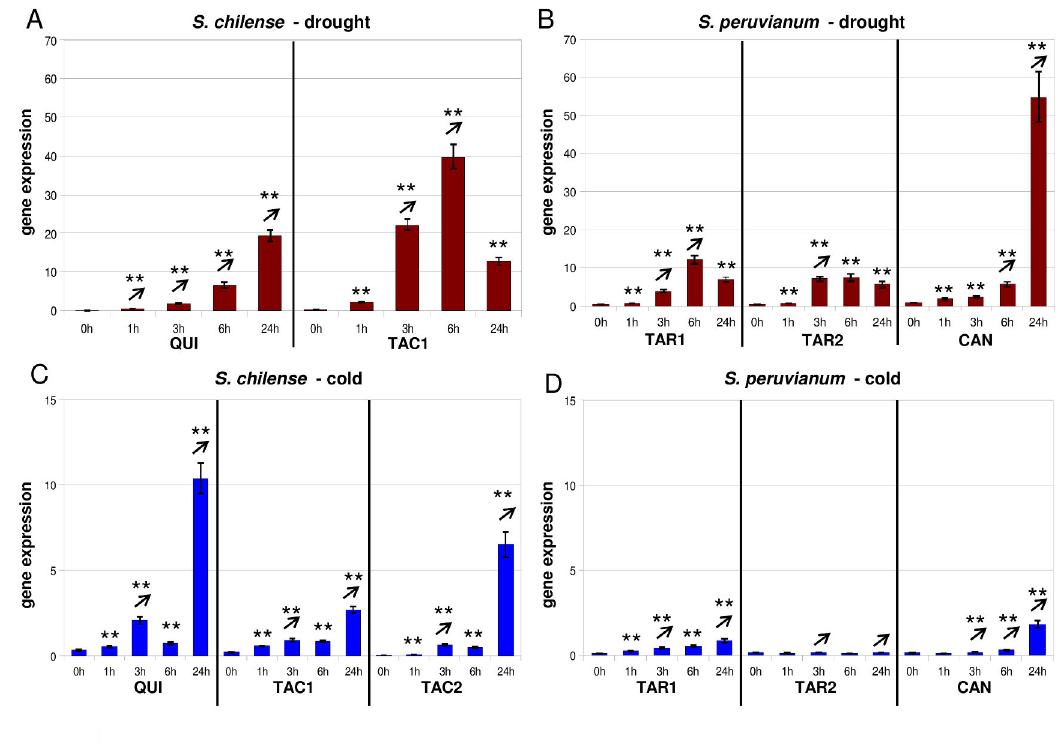
Figure 4. Gene expression of pLC30-15 after application of drought and cold stress. (for explanation see Figure 1). doi: